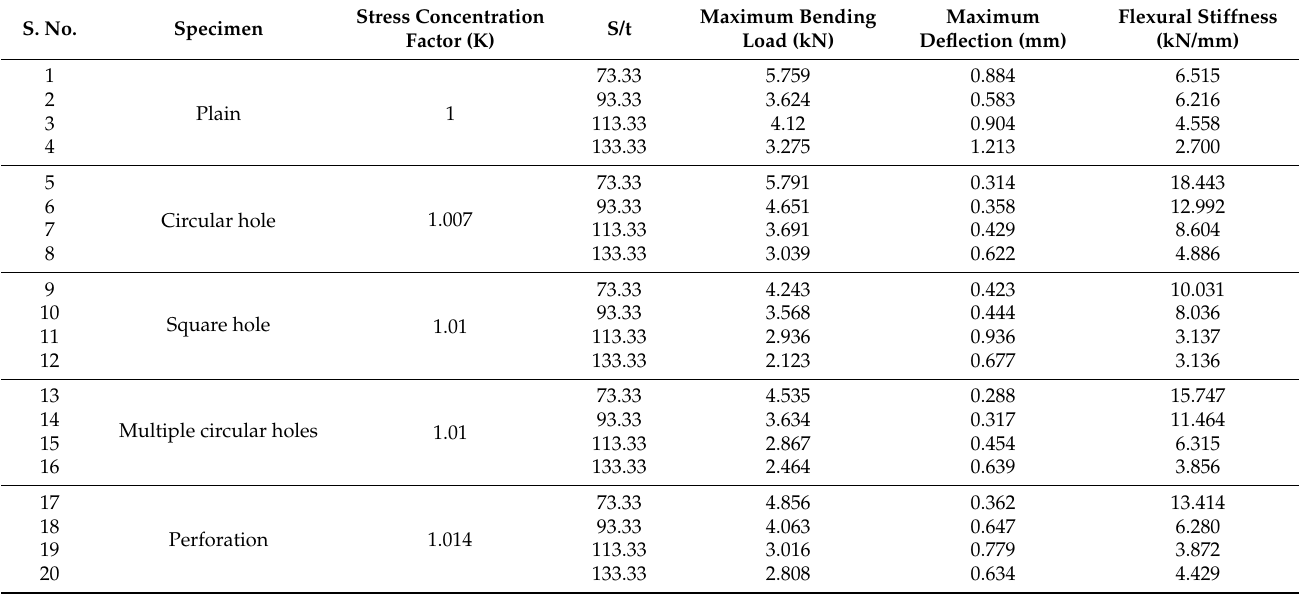
Table 3. Experimental flexural performance